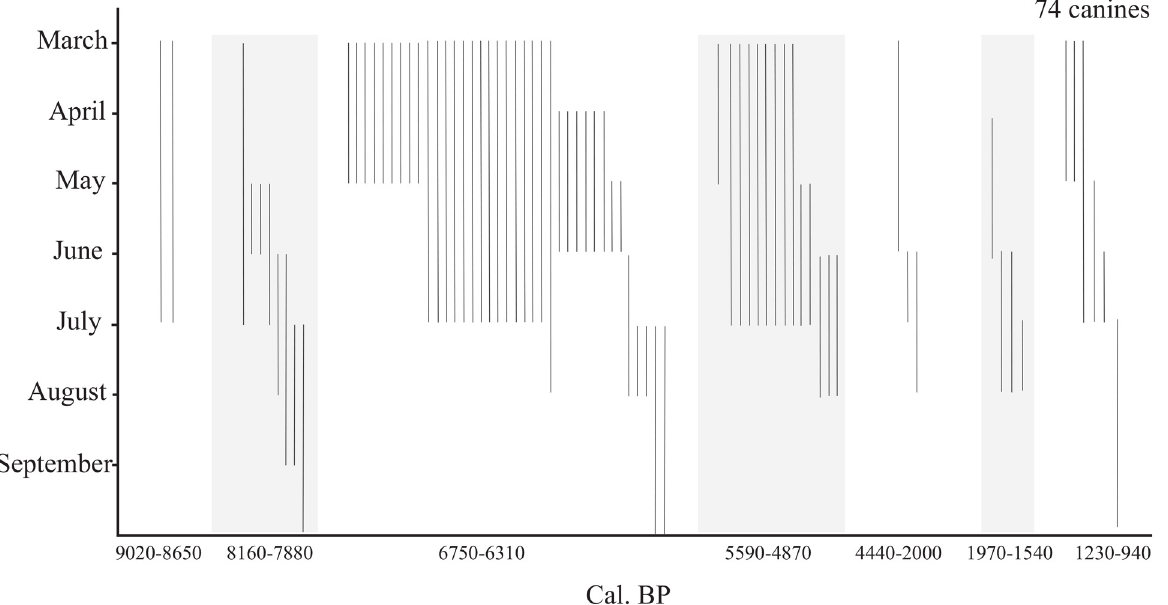
Fig 7. Seal seasonality data at Sagan-Zaba II by time period. Each bar represents a season of death estimate for a single individual.